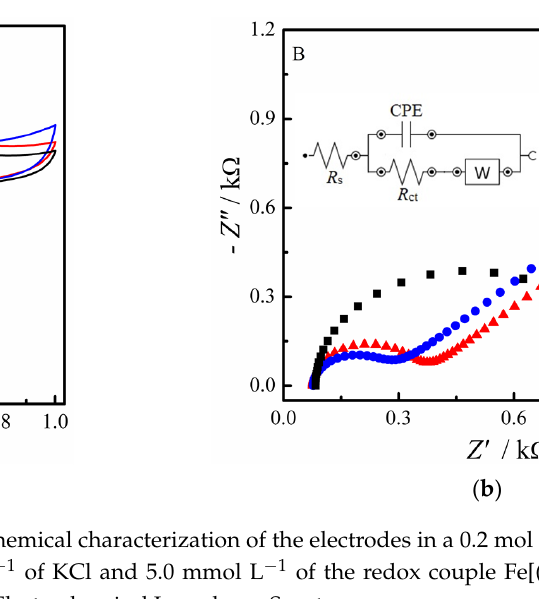
Voltammetry; ( b ) Electrochemical Impedance Spectroscopy.